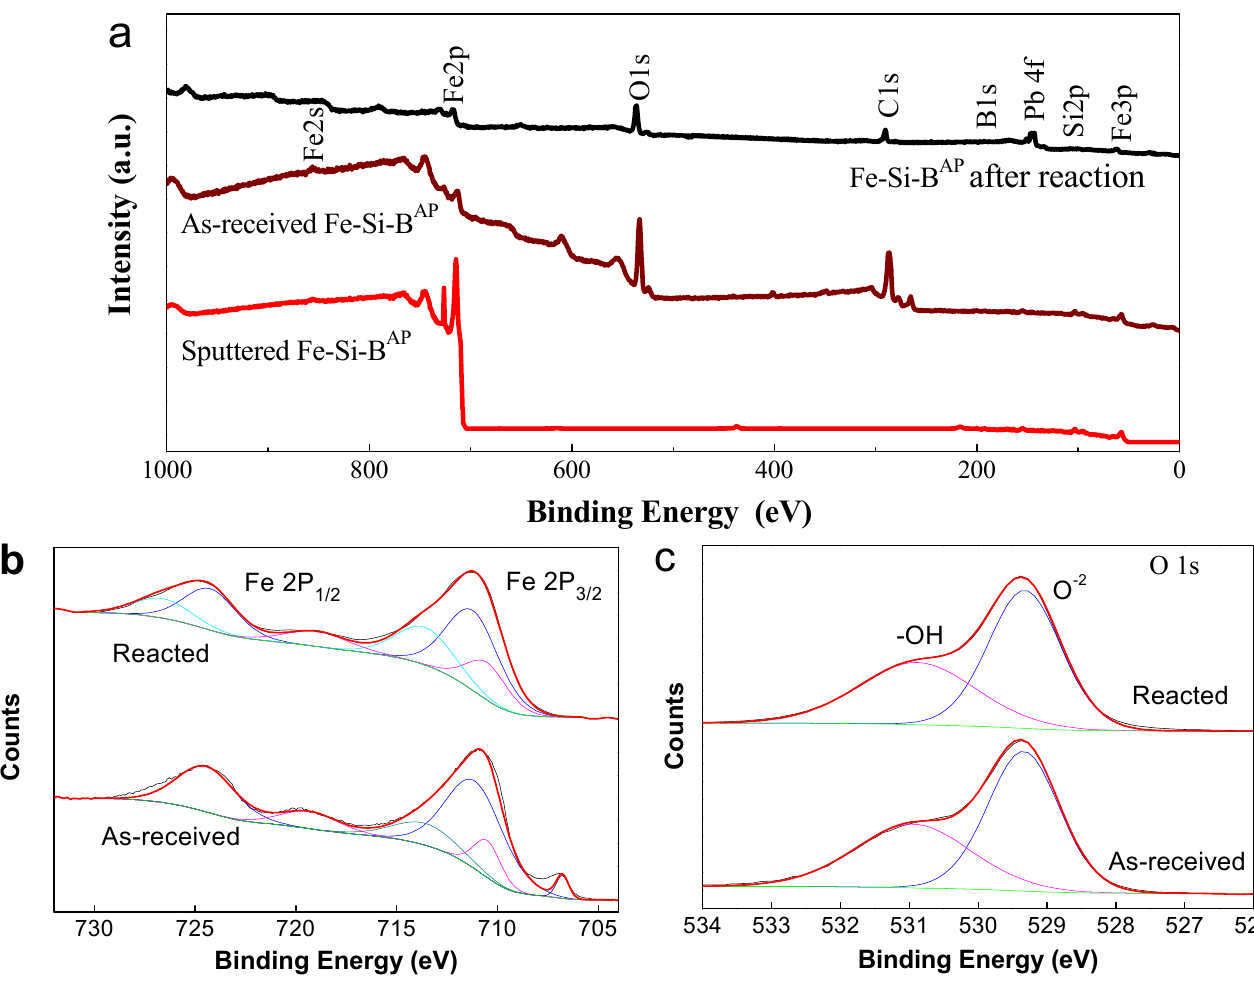
Figure 7. XPS spectra of FeSiB AR before and after reaction: ( a ) whole XPS, ( b ) Fe 2p, ( c ) O 1s. SEM images of the precipitate and reacted FeSiB AR were also observed. Figure 8 shows microscopic morphology of the precipitate. The main features observed are a large number of particles with a size of about 5 µ m surrounded by a thin layer of reaction product. It can be seen from the enlarged image in Figure 8b that the particles are surrounded by a villous product layer. EDS elemental analyses in Figure 8d show that the particles are mainly Pb crystallines. This result is in accordance with the XRD analyses that show that the precipitates are mainly Pb. The irregular multi-prism morphology of crystal Pb can be clearly seen from the backscattered electron image of the particles in Figure 8c due to the large difference in atomic number between Pb and the other